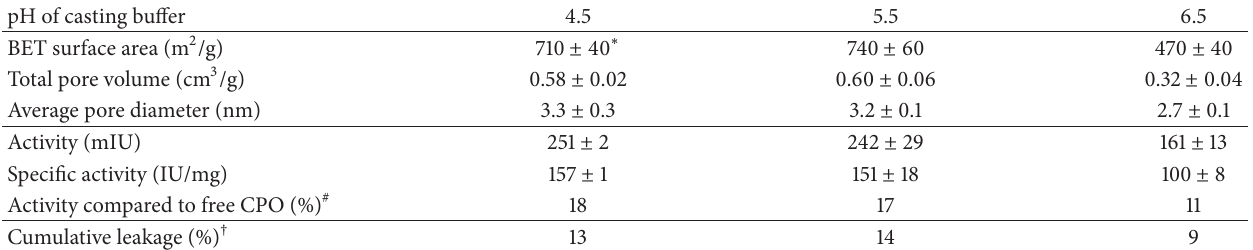
Table 3: Properties of CPO sol-gel beads prepared with different casting buffers.